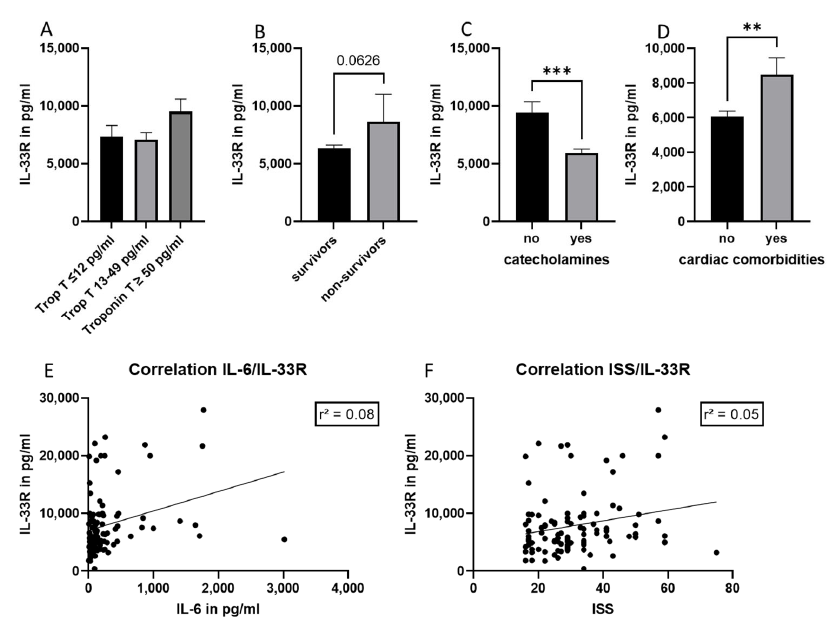
Figure 2. Interleukin 33 receptor (IL ‐ 33R) level in different groups of polytrauma patients. ( A ) IL ‐ 33R concentration in different troponin T patient subgroups. ( B ) IL ‐ 33R concentration in survivors and non ‐ survivors. ( C ) IL ‐ 33R concentration in patients with (yes) and without (no) need in cate ‐ cholamines. ( D ) IL ‐ 33R concentrations in patients with and without cardiac comorbidities. ( E ) Cor ‐ relation analysis between IL ‐ 33R and IL ‐ 6 plasma concentrations. ( F ) Correlation analysis between IL ‐ 33R plasma concentrations and the injury severity score (ISS). n = 107 patients, ** p ≤ 0.01; *** p ≤